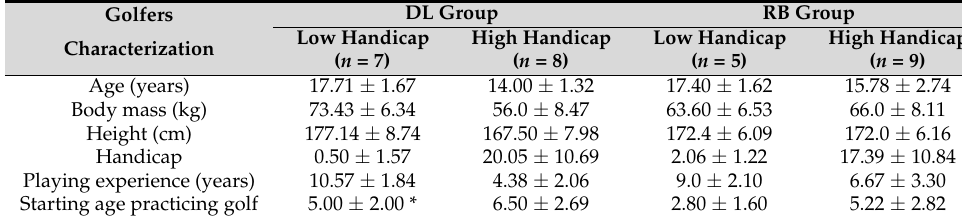
Table 1. Golfers’ characteristics according to the different training groups.